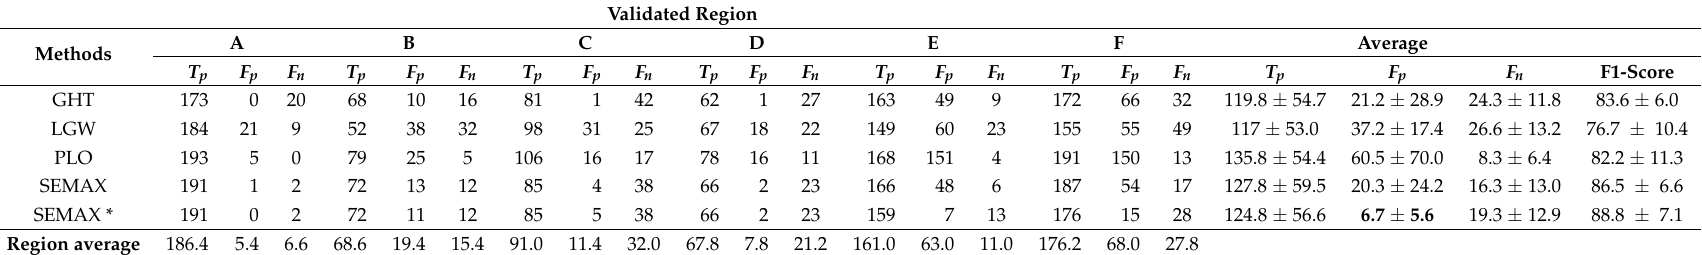
Table 3. Classifier accuracy performed by the compared individual tree detection (ITD) approaches. Notation * stands for SEMAX version that incorporates a classifier